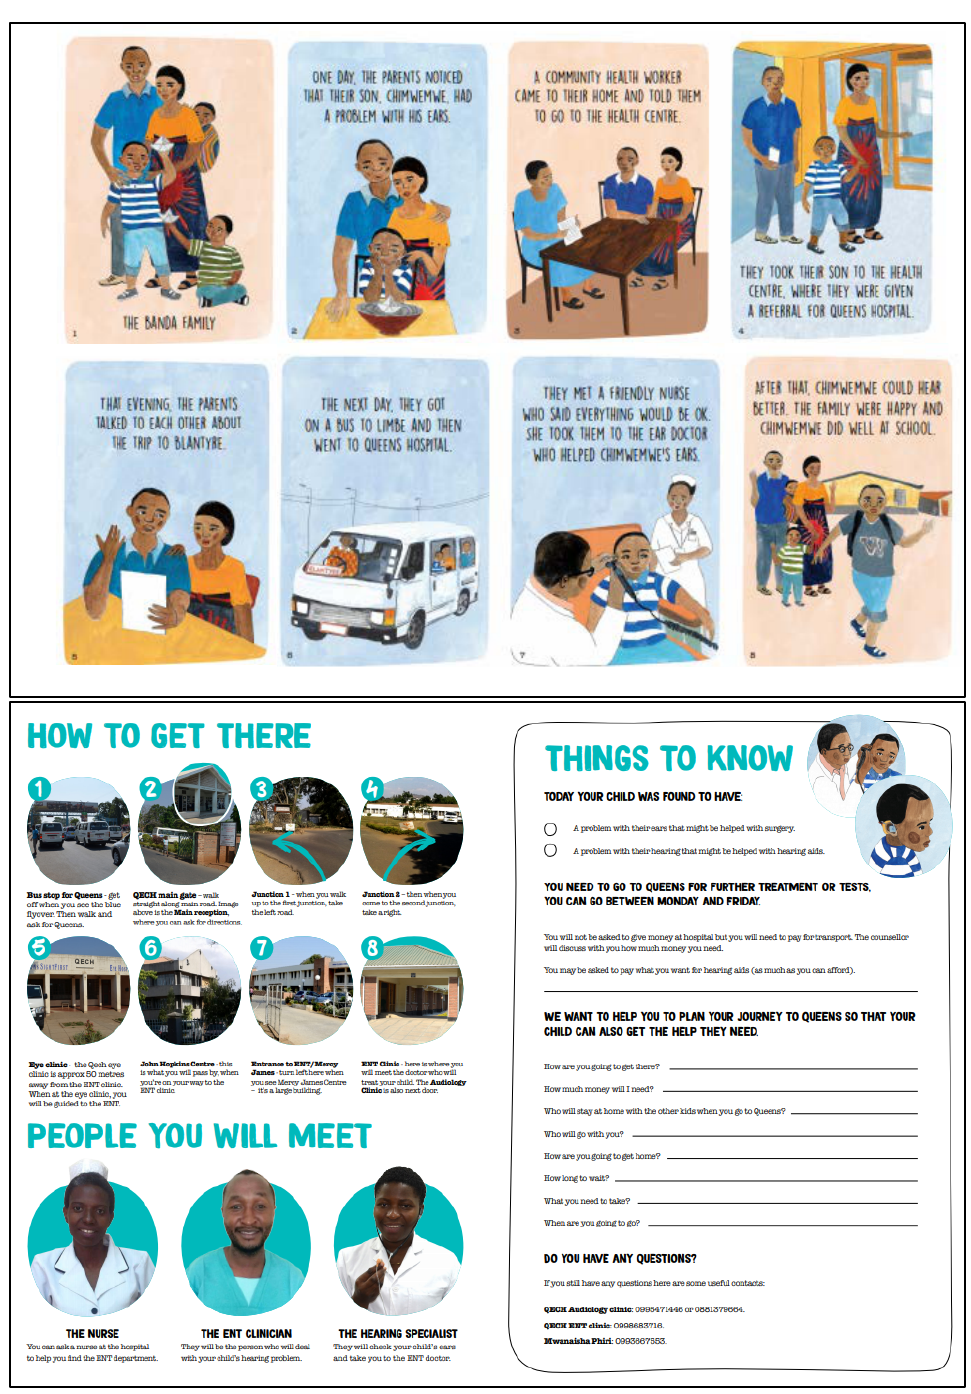
Figure 2. Final English version of the information booklet for Malawi intervention, before translation into Chichewa. The set of illustrated images at the top show the storyline, and the bottom shows further information about how to get to the hospital, the people that will be met, and a section on action planning (things to know) which was tailored to the individual family. The booklet was folded down to A6 format with page 1 of the booklet showing the first panel of the story (The Banda Family).